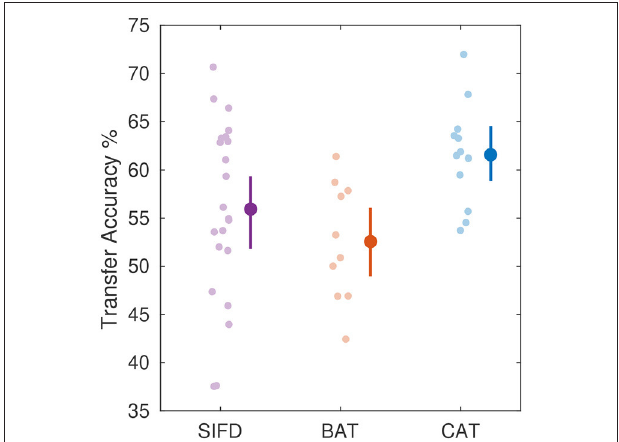
FIGURE 2 | Average transfer task performance for the three training conditions. The combined adaptive training (CAT) resulted in better transfer task performance compared to behavior adaptive training (BAT) and fixed difficulty (SIFD) conditions. The large dots show the sample average, and the small dots show individual data points. Error bars show 95% confidence intervals from bias corrected, accelerated percentile